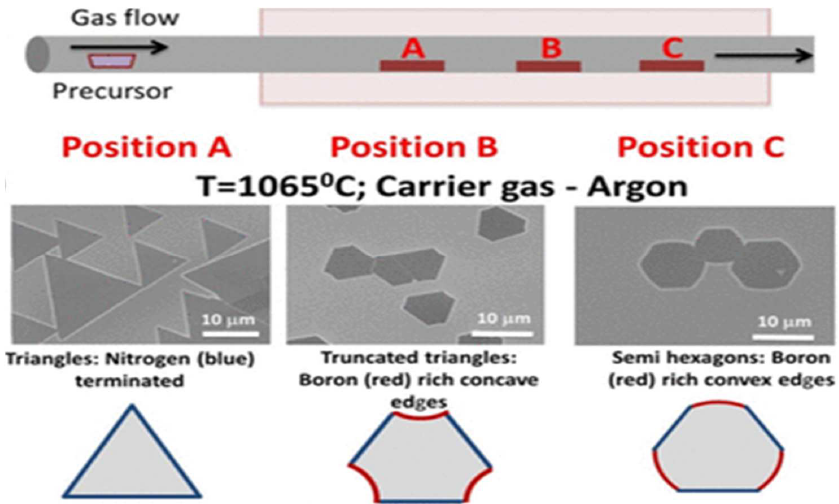
Figure 17. APCVD experimental setup for h-BN growth and APCVD experimental setup for h-BN growth [76].